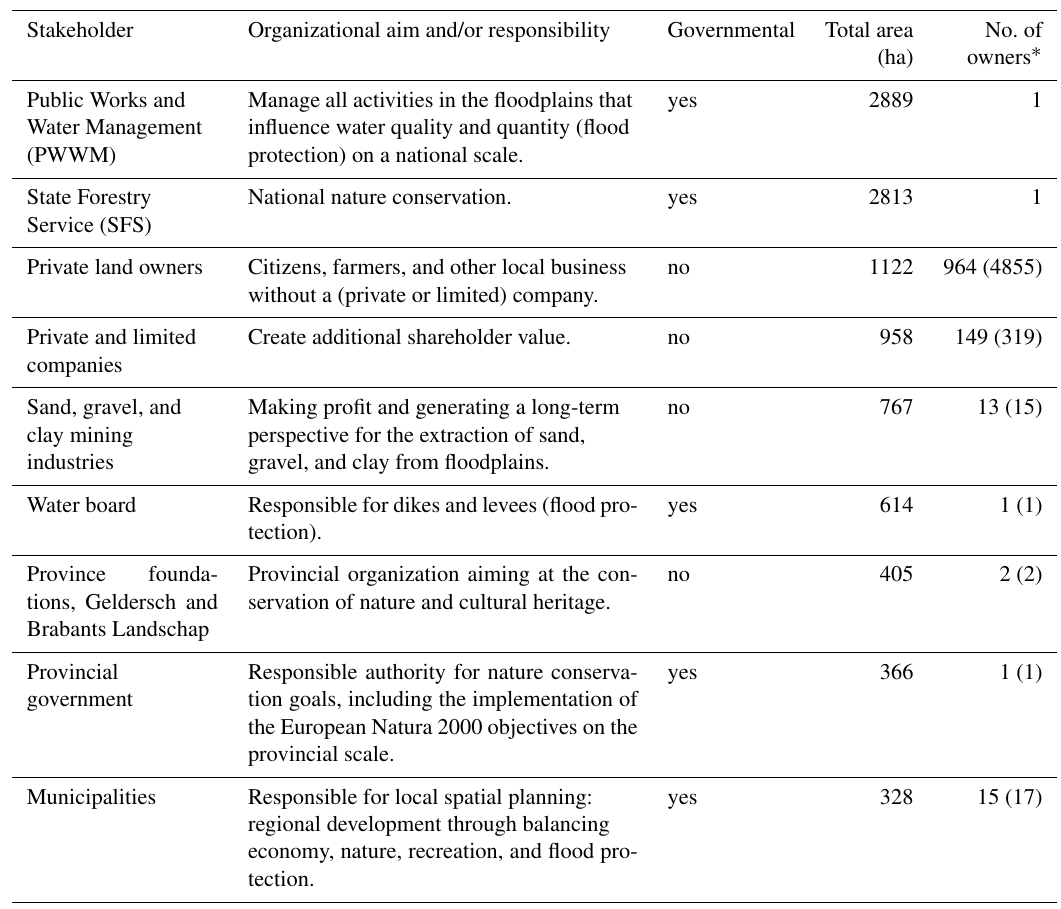
Table 1. Characteristics of nine land owner types involved in the maintenance of floodplains (based on Fliervoet and Van den Born, 2017). The remaining area is owned by foundations (66) and churches (20).